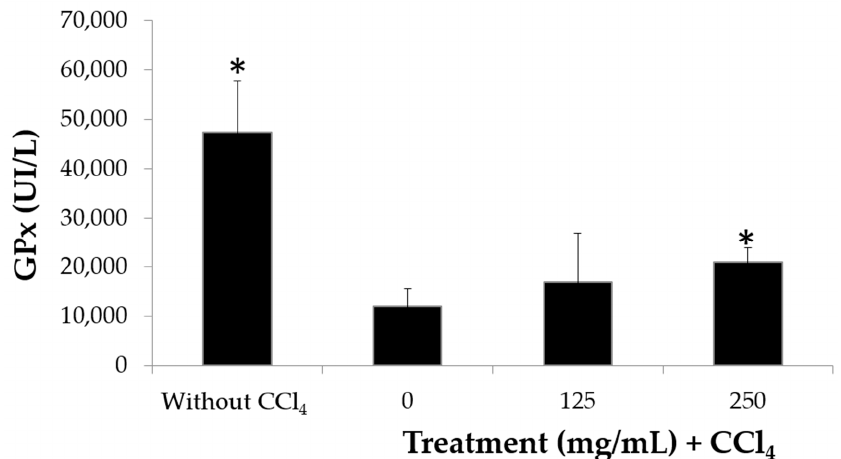
Figure 6. Concentration of glutathione peroxidase glutathione peroxidase (GPx) in blood lysates of mice treated or not treated with the H387 07 extract for a month with or without induction of oxidation by carbon tetrachloride (CCl 4 ). n = 10 mice per treatment ± standard deviation. * Significant difference (Tukey p < 0.05).